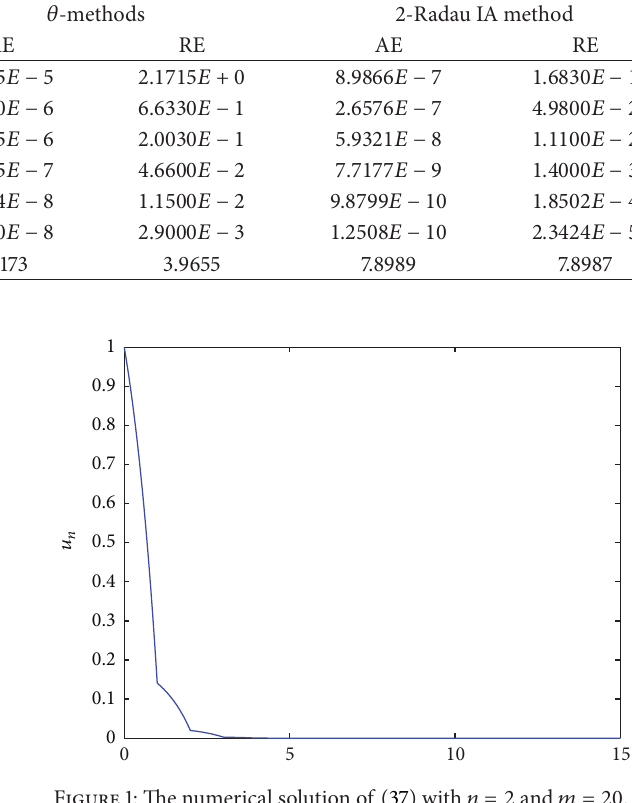
Figure 1: The numerical solution of (37) with 𝑛 = 2 and 𝑚 = 20